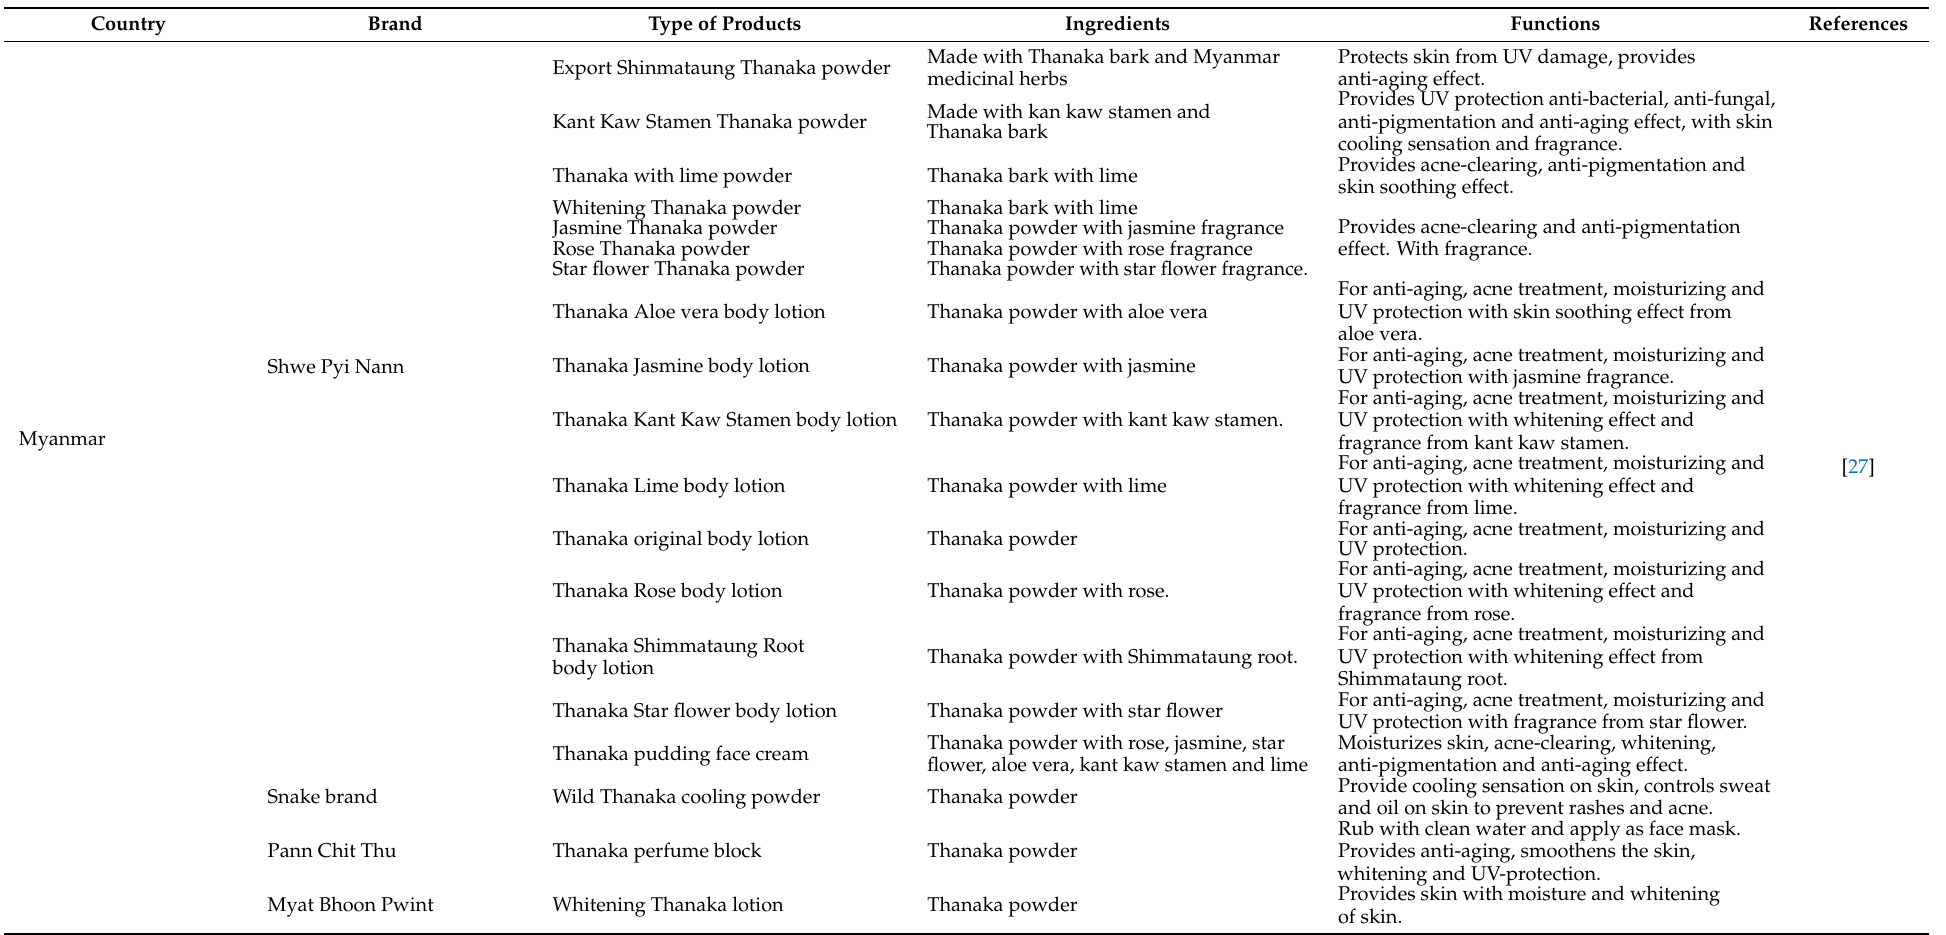
Table 4. Some of Thanaka products in the market in Southeast